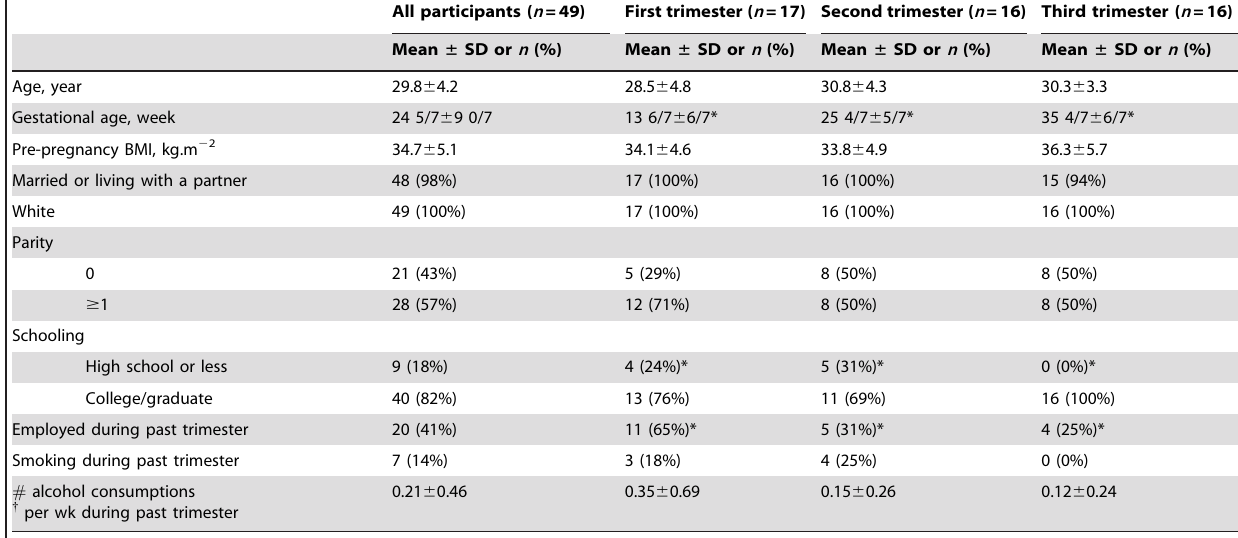
Table 1. Women’s characteristics.